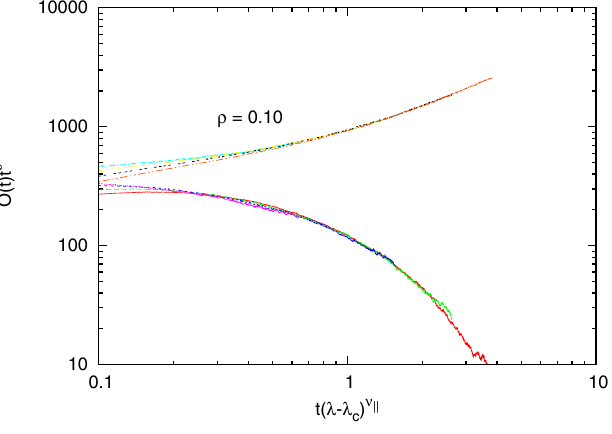
Fig. 5. Variation of average opinion with time at critical points for (cid:1) ¼ 0 : 10 . The value of (cid:7) jj (cid:6) 1 : 40 (cid:5) 0 : 05